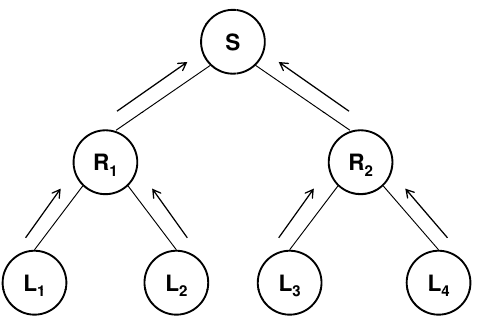
Figure 2. Many-to-one